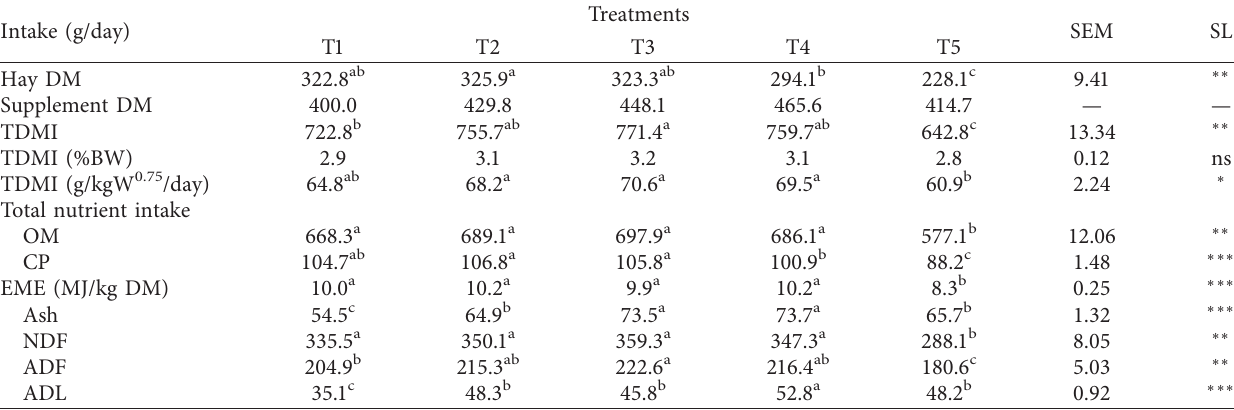
Table 3: Mean daily dry matter and nutrient intake of growing Bonga lambs fed on Rhodes grass hay basal diet and supplemented with dried mulberry and Vernonia mixed leaves’ meal substituting noug seed cake of concentrate mix at different levels. Treatments Intake (g/day)